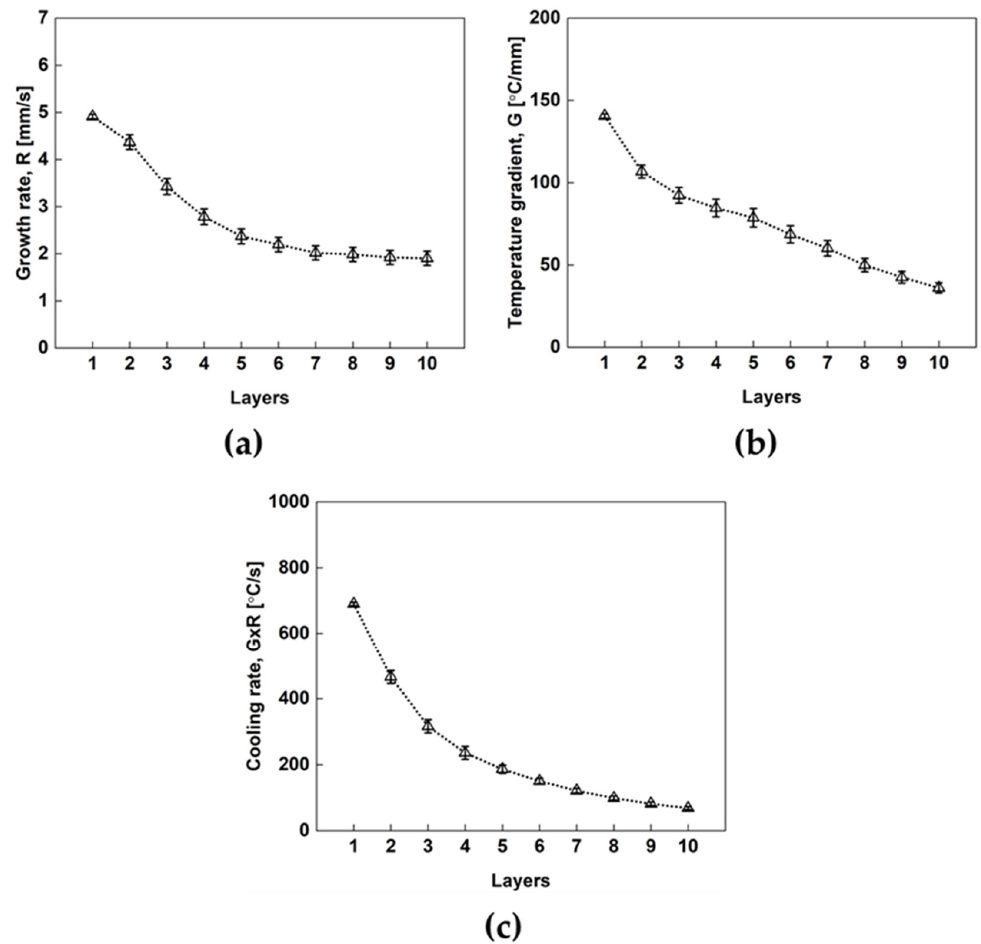
Figure 5. ( a ) G, ( b ) R, and ( c ) G × R of each layer of deposits.